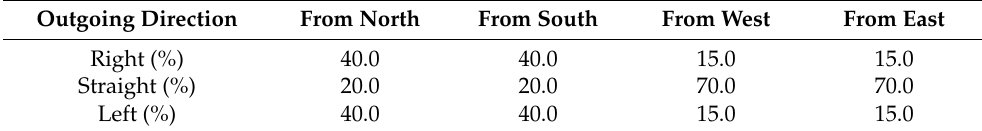
Table 2. Percentage of outgoing flow.